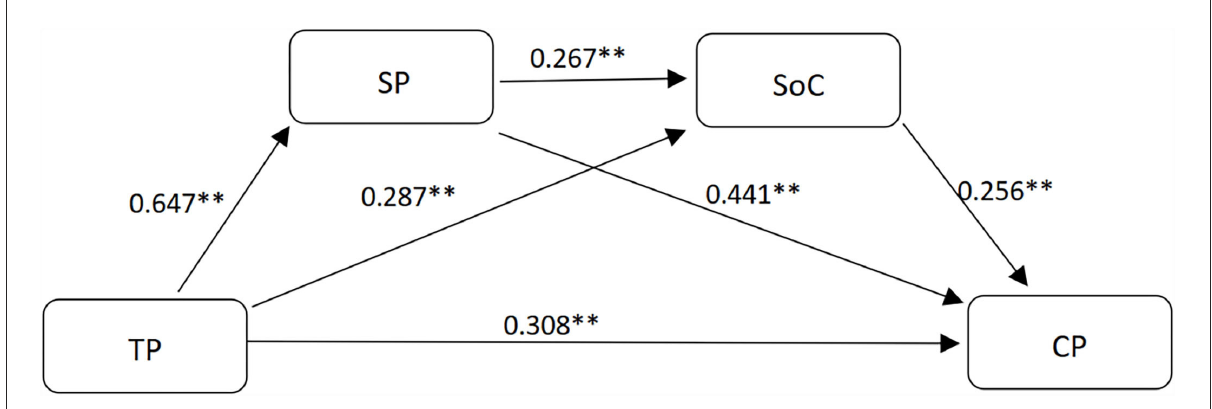
FIGURE1 The mediation model. TP means teaching presence, SP means social presence, SoC means sense of community, CP means cognitive presence. ** p < 0.001.